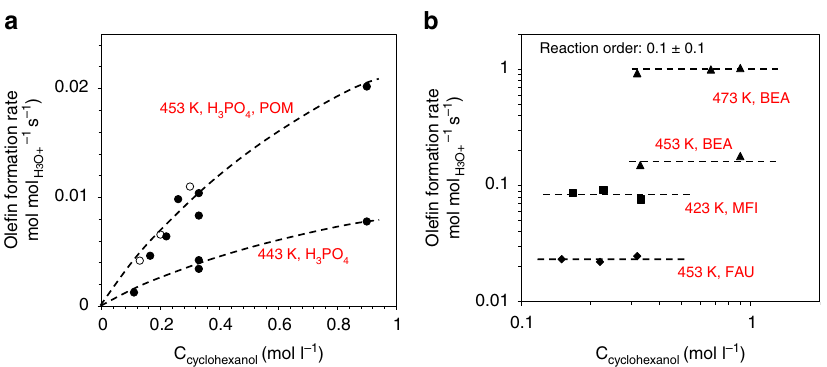
Figure 2 | Turnover frequencies of aqueous-phase cyclohexanol dehydration on different acid catalysts as a function of cyclohexanol concentration. ( a ) Soluble acids (closed circles: H 3 PO 4 , open circles: heteropoly acids); ( b ) MFI, BEA and FAU zeolites. Rates were determined at conversions o 10%. Dashed lines serve to guide derived using a single-site Langmuir adsorption model to fit the measured isotherms (Table 1). Adsorption enthalpies ( D H ads (cid:2) )